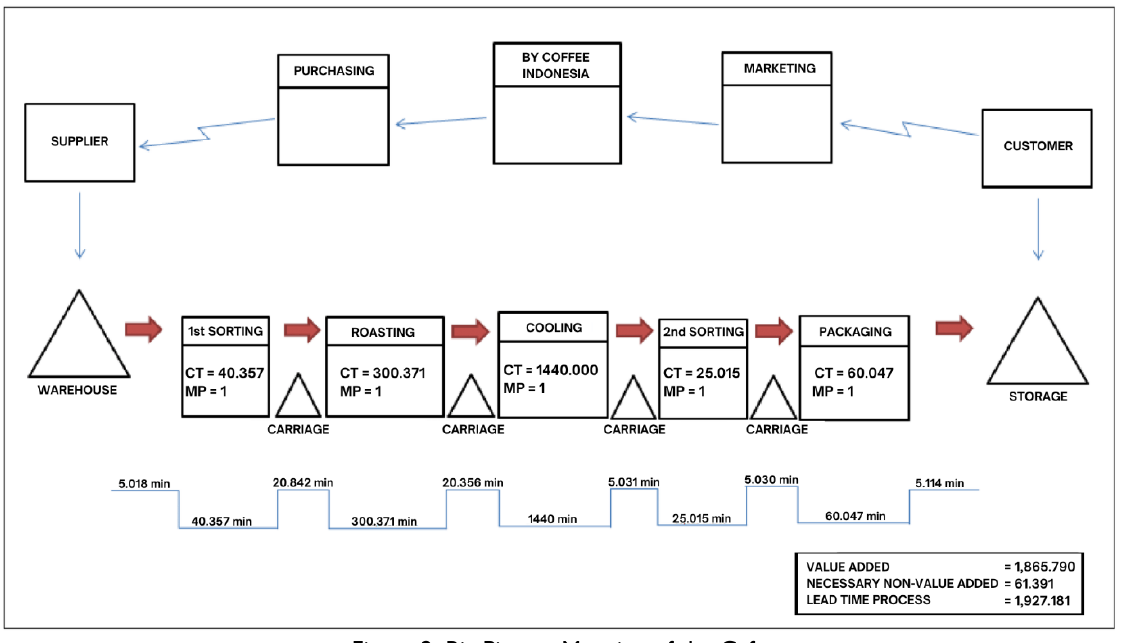
Figure 2. Big Picture Mapping of the